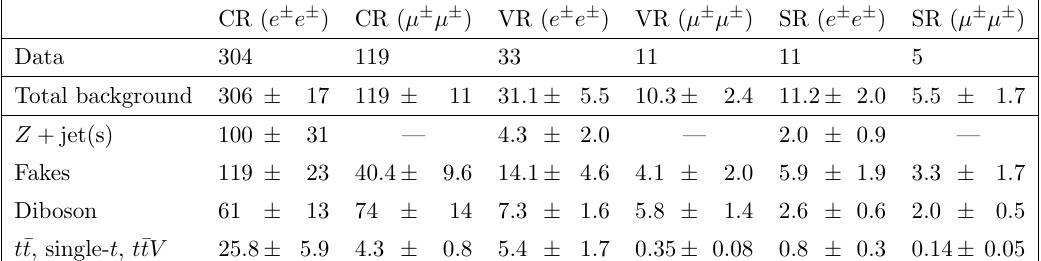
Table 7 . Numbers of expected background events in analysis regions after the background-only (cid:12)t in the same-charge channel, compared to the data. The quoted uncertainties correspond to the total uncertainty in the predicted event yield including correlations between the various sources of systematic uncertainties. Due to rounding the total background can di(cid:11)er from the sums of components. Diboson and Z + jet(s) yields are (cid:13)oating in the (cid:12)t. Background processes with a negligible yield are marked with the dash